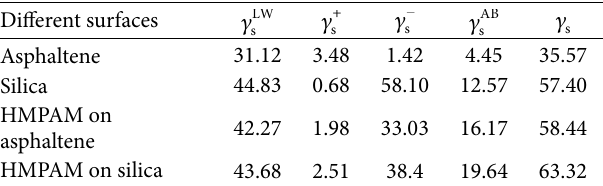
Table 3: Surface free energy (mJ/m 2 ) of different surfaces.